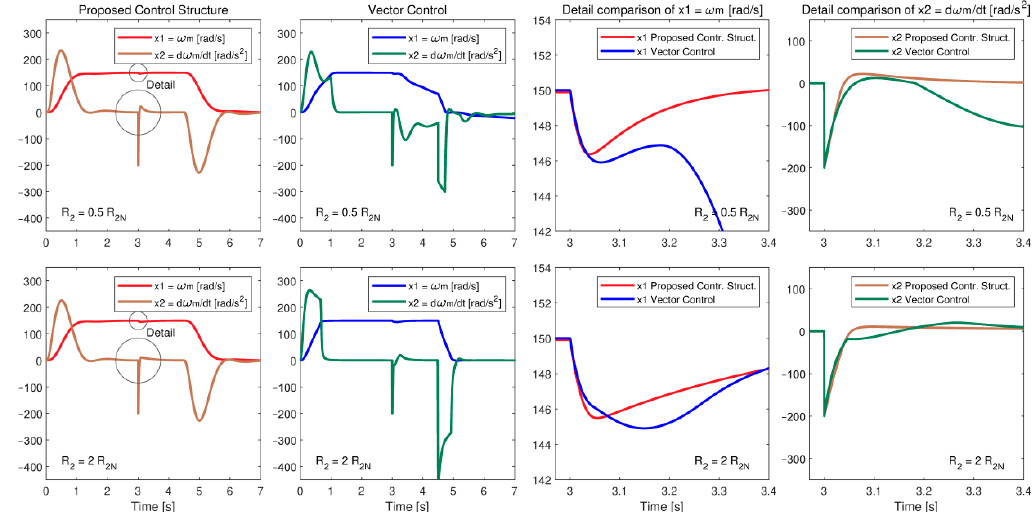
Figure 12. Comparison of the proposed and the vector control structures for change of the rotor resistance to the values R 2 = 0.5 R 2 N and R 2 = 2 R 2 N .